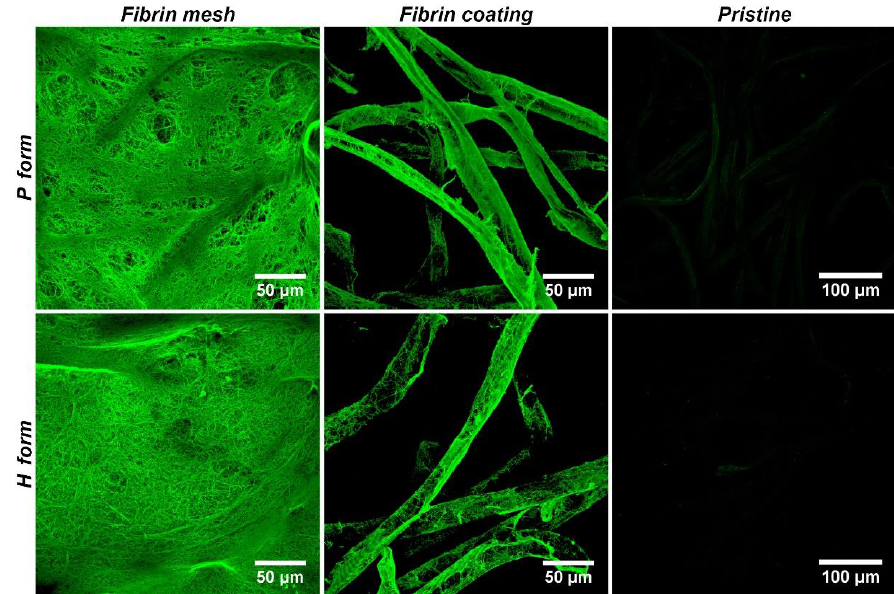
Figure 2. Morphology of the P form and the H form of Hcel ® NaT modified with a fibrin mesh or a fibrin coating. The pristine Hcel ® NaT of P form and H form were used to show non-specific binding of the antibodies. The fibrin was stained with a primary polyclonal rabbit antibody against fibrinogen and with a secondary antibody conjugated with Alexa 488 (green fluorescence). Leica TCS SPE DM 2500 confocal microscope, magnification 40 × /1.15 NA oil or magnification 20 × /0.70 NA